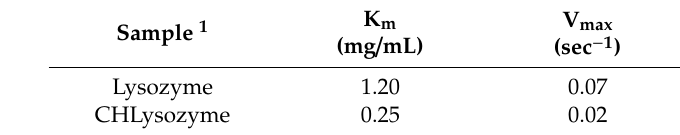
Table 2. K m and V max of lysozyme and CHLysozyme calculated from Lineweaver-Burk plot.